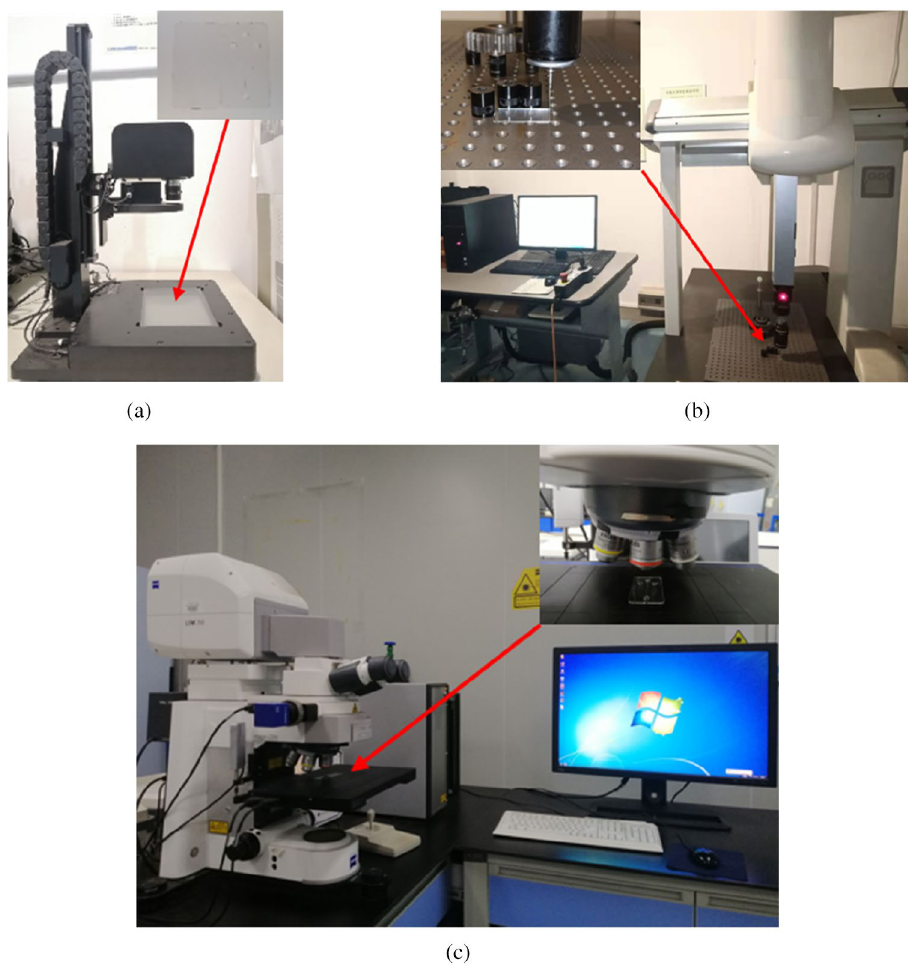
Figure 4. The test equipment for protein electrophoresis microfluidic chip. ( a ) The double refraction instrument. ( b ) The three-coordinate measuring system. ( c ) The laser scanning confocal